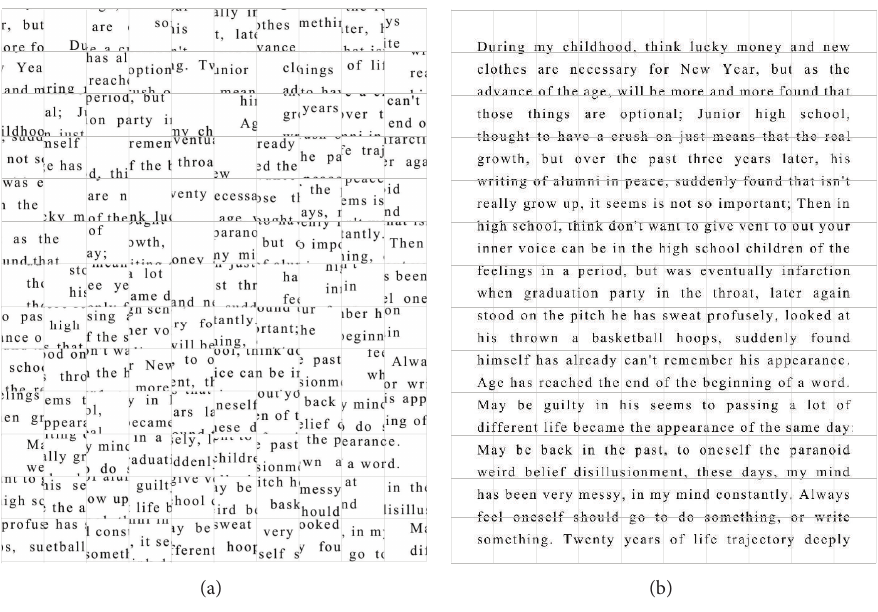
Figure 2: The cross-cut shredded text document (a) and the fully reconstructed document